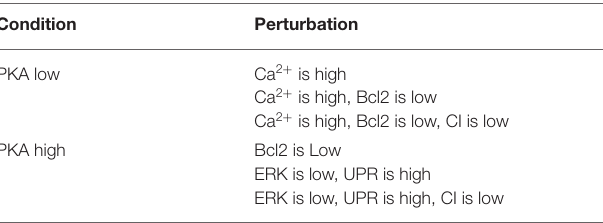
TABLE 1 | Optimal perturbations found by NSGA-II, using 2 objective functions, in both PKA high and low conditions.